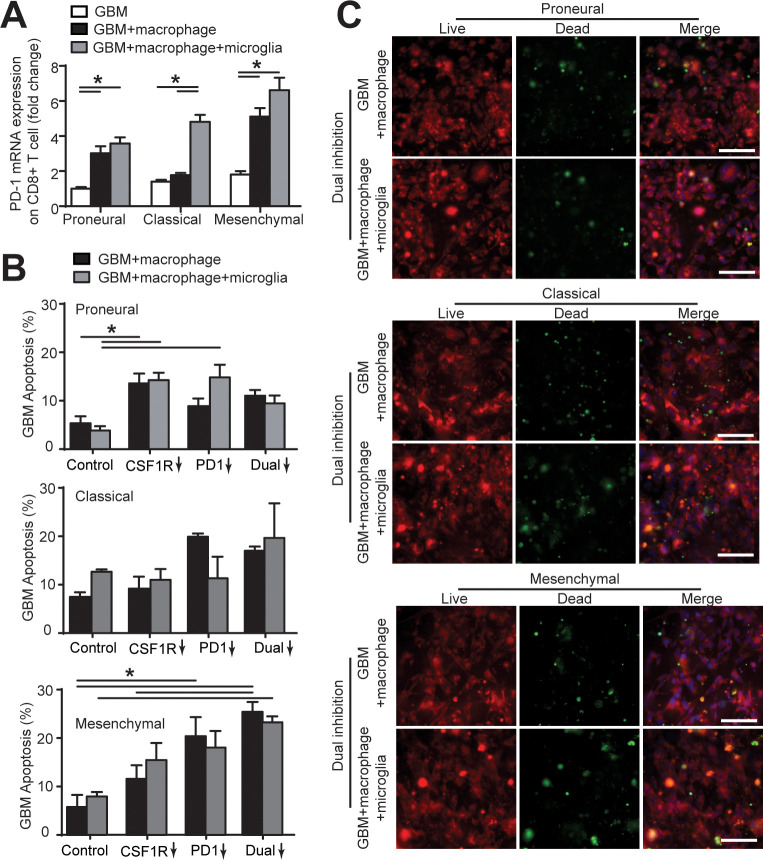
Microglia affect CD8+ T-cell PD-1 expression and GBM cell apoptosis.(A) mRNA expression of PD-1 in CD8+ T-cell in the PN (GBML20), CL (GBML08), and MES (GBML91) GBM niches. Of note, PD-1 expression in CD8+ T-cell co-cultured with GBM, PBMC-derived macrophages and brain-resident microglia was higher than that of those CD8+ T-cells co-cultured with GBM only or GBM and macrophages. (B) Quantified GBM cell apoptosis with the presence or absence of microglia cells in the PN (GBML20), CL (GBML08), and MES (GBML91) GBM microenvironments with CSF-1R inhibitor BLZ945 (0.1 μg/ml), PD-1 blockade nivolumab (1 μg/ml) monotherapy or dual inhibition treatment. Control groups were treated with fresh cell culture media supplemented with DMSO (0.01%) and human IgG4 isotype control antibody (1 µg/mL, BioLegend). These results with the presence of microglia showed no significant difference with the GBM and macrophage only condition. (C) Representative images showing GBM cell apoptosis (green) with or without the presence of microglia cells in the PN (GBML20), CL (GBML08), and MES (GBML91) GBM microenvironments under dual blockages of CSF-1R and PD-1. Scale bar is 100 μm. Error bars represent ± s.e.m. p-Values were calculated using one-way ANOVA. *, p<0.05.